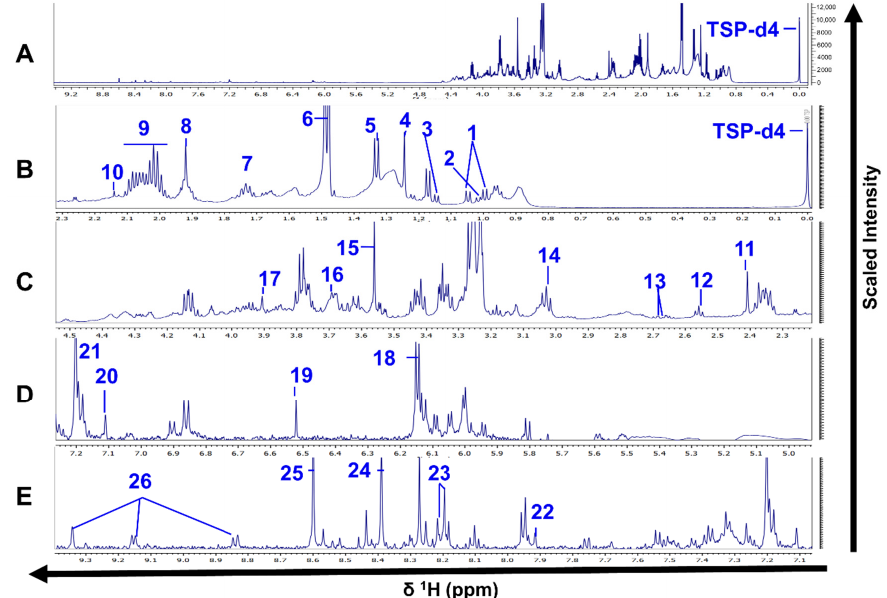
Figure 2. 1 H-NMR spectra of L. tropica intracellular extracts. ( A ) Full 1 H-NMR spectrum from δ 0.0 to δ 9.3. ( B ) Enlarged spectrum from δ 0.0 to δ 2.3. ( C ) Enlarged spectrum from δ 2.3 to δ 4.5. ( D ) Enlarged spectrum from δ 5.0 to δ 7.2. ( E ) Enlarged spectrum from δ 7.1 to δ 9.3. Peaks of 26 compounds: 1, valine; 2, isoleucine; 3, propylene glycol; 4, 3-hydroxyisovalerate; 5, lactate; 6, alanine; 7, arginine; 8, acetate; 9, proline; 10, methionine; 11, succinate; 12, β -alanine; 13, malate; 14, lysine; 15, glycine; 16, glycerophosphocholine; 17, betaine; 18, IMP; 19, fumarate; 20, ∂ -methylhistidine; 21, desaminotyrosine; 22, xanthine; 23, hypoxanthine; 24, Formate; 25, AMP; 26, NAD. TSP-d4 as an internal standard with chemical shift at δ 0.0. Only one spectrum is represented for simplification. The spectrum corresponds to the HR strain.